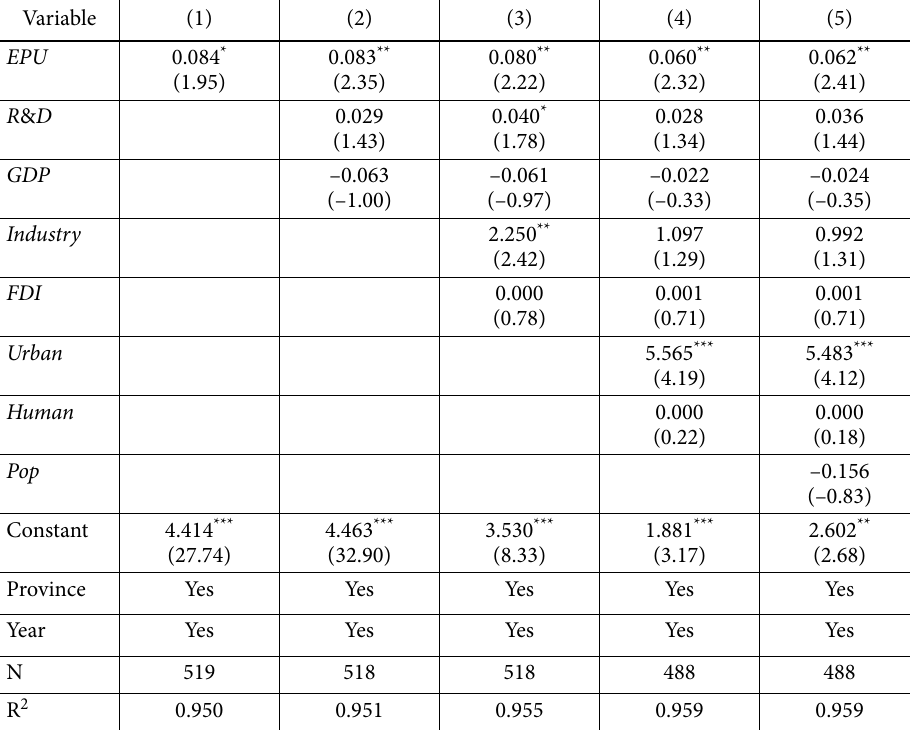
Table 4. Estimation results of the two-way panel fixed effect model